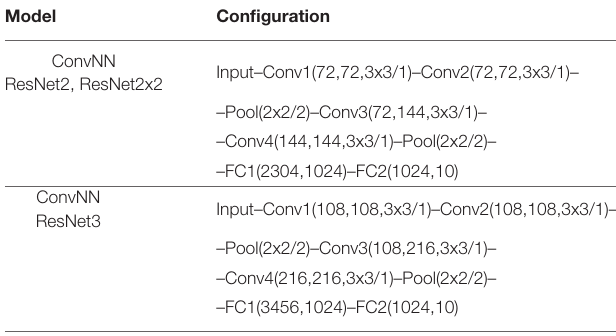
TABLE 10 | Accuracy for AGD trained SNN of VGG3 topology (refer to last row) for different latency T = 5,10,25 on CIFAR10 data.